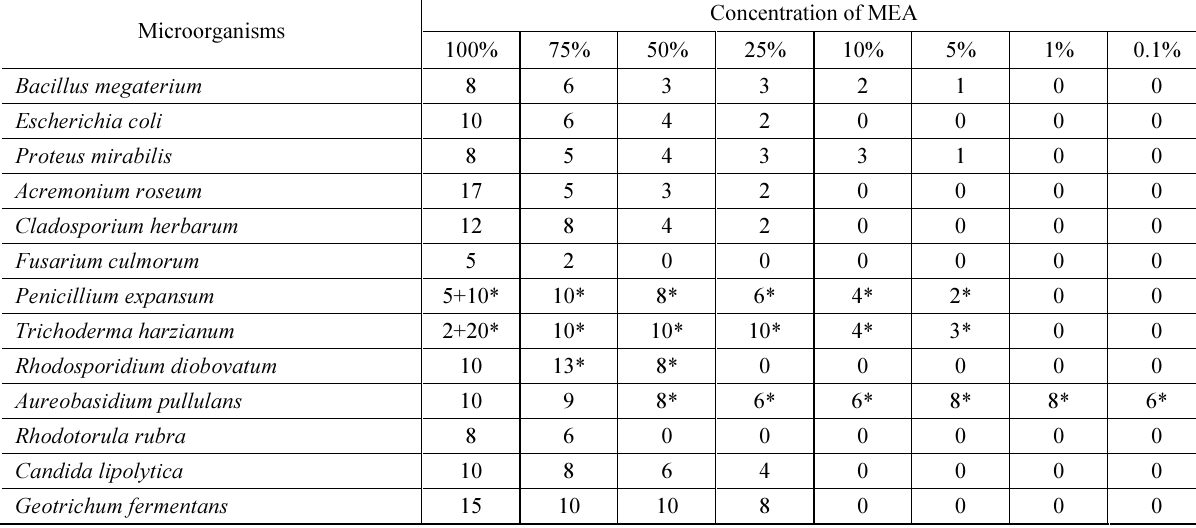
Concentration of MEA